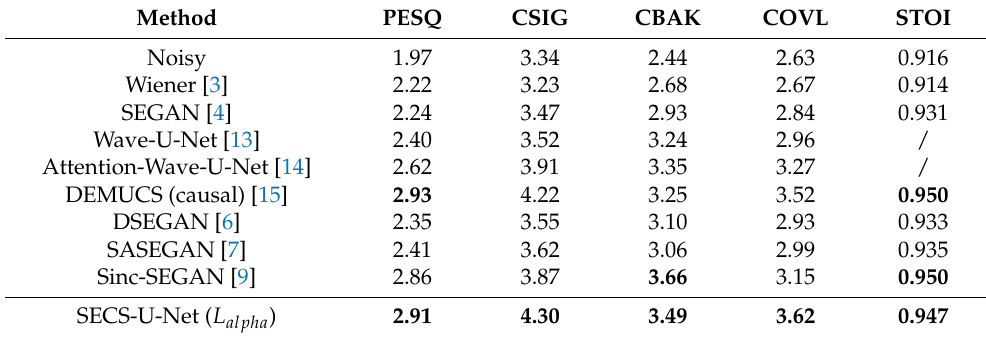
Table 3. Objective evaluation results of the proposed method and the reference methods (the bold indicates our metric scores and the metric scores that exceed ours in the reference